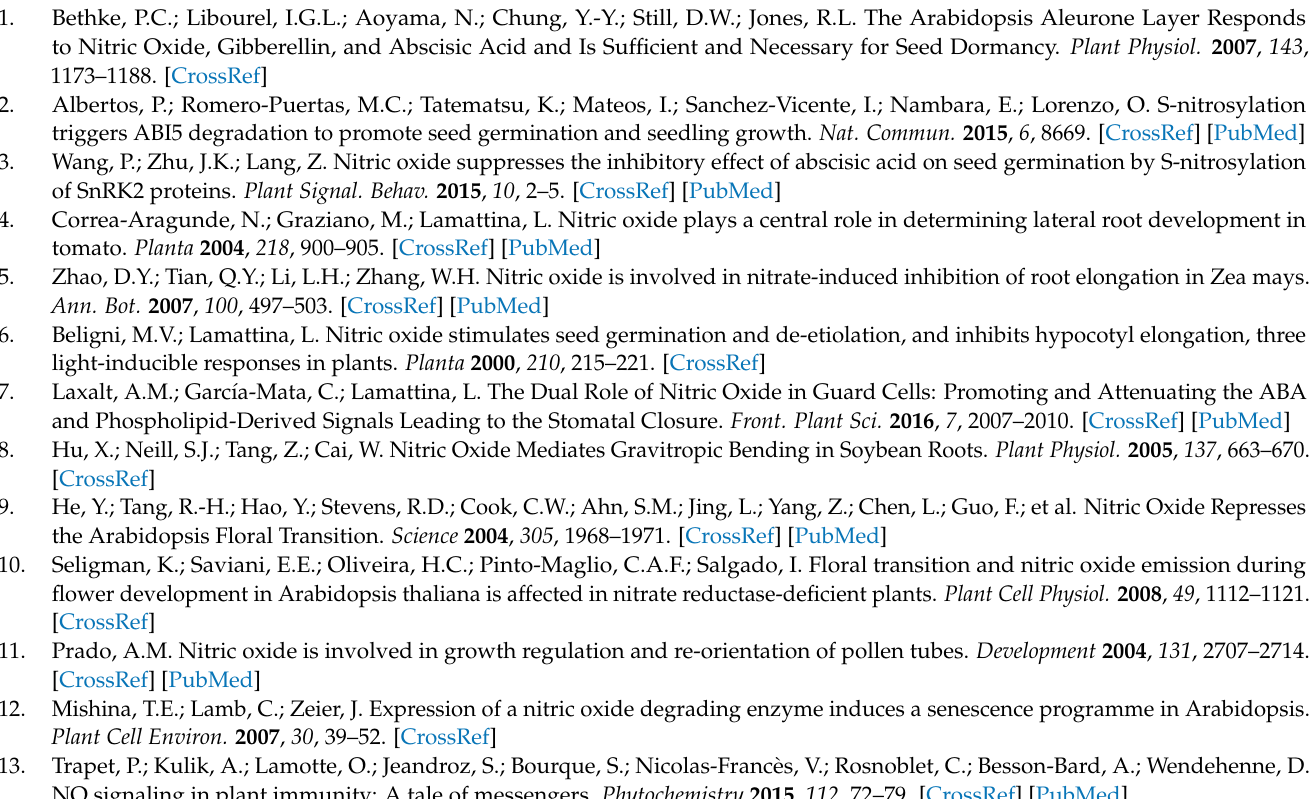
Supplemental Figure S5. DNA methylation is poorly correlated with gene expression differences in gsnor1-3 . Supplemental Figure S6. DNA methylation is poorly correlated with gene expression differences in sahh1